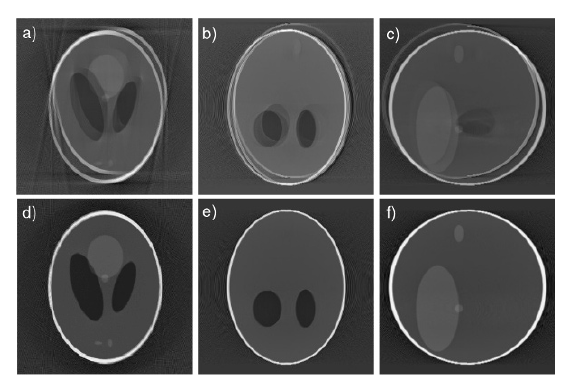
Figure 18. (a–c) axial, coronal and sagittal slices of the translational motion corrupted case; (d–f) same slices after motion compensation.